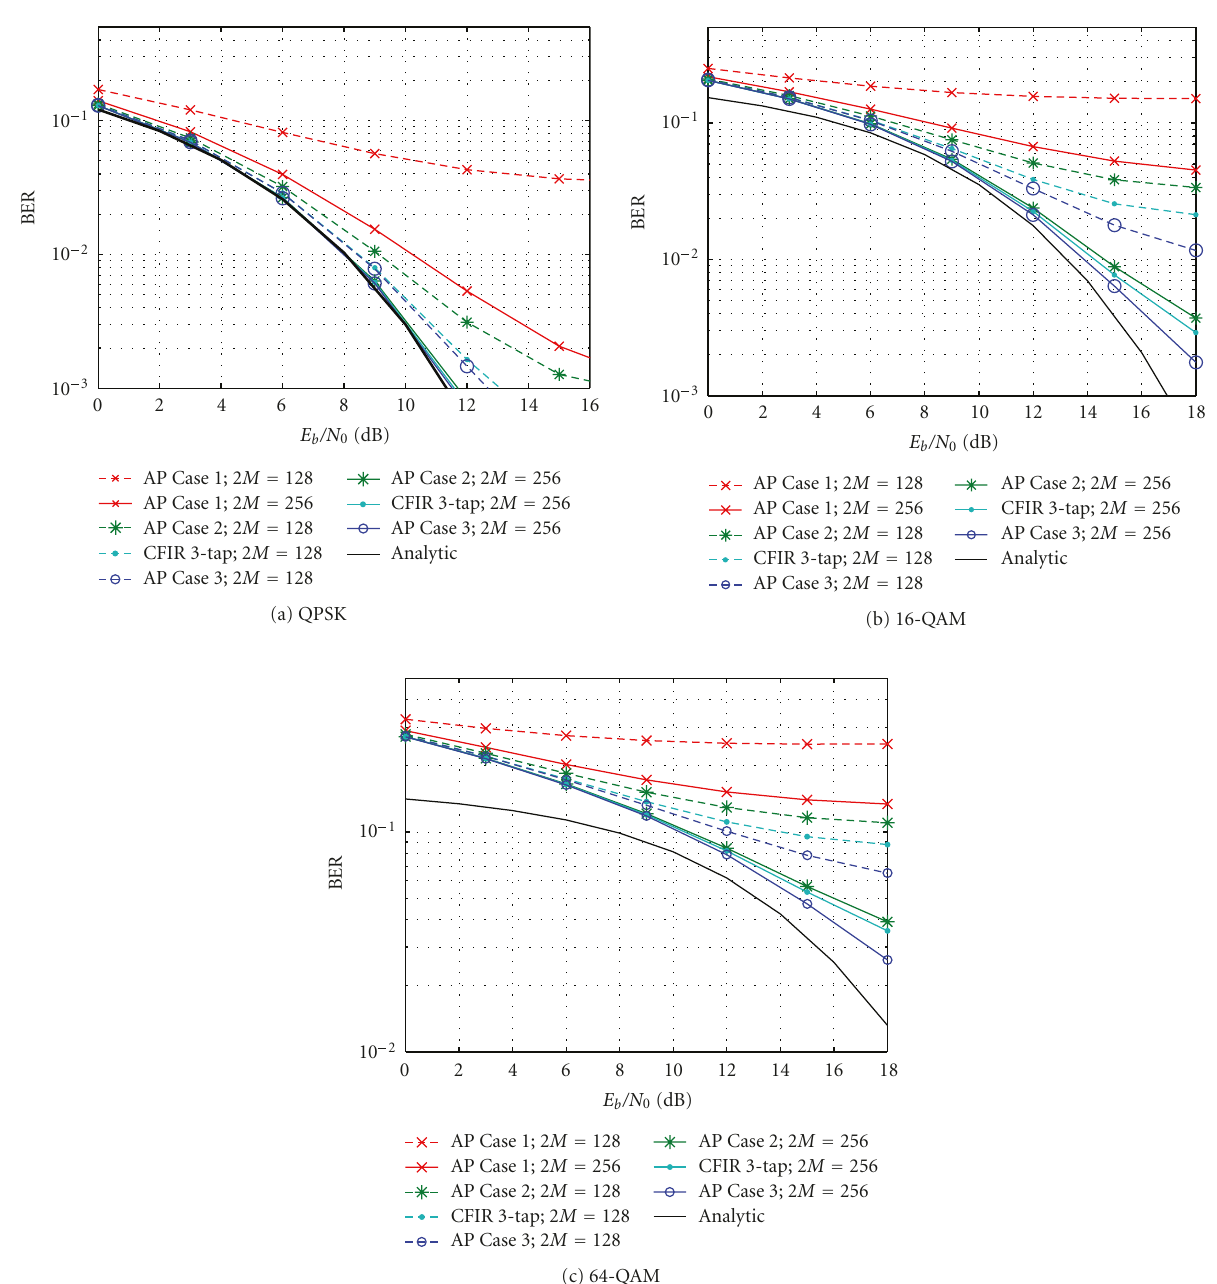
Figure 7: Uncoded BER performance of FB-FSE (CFIR-FBEQ 3-tap and AP-FBEQ Cases 1, 2, 3) with overlapping factor K = 5 and 2 M = { 128,256 }